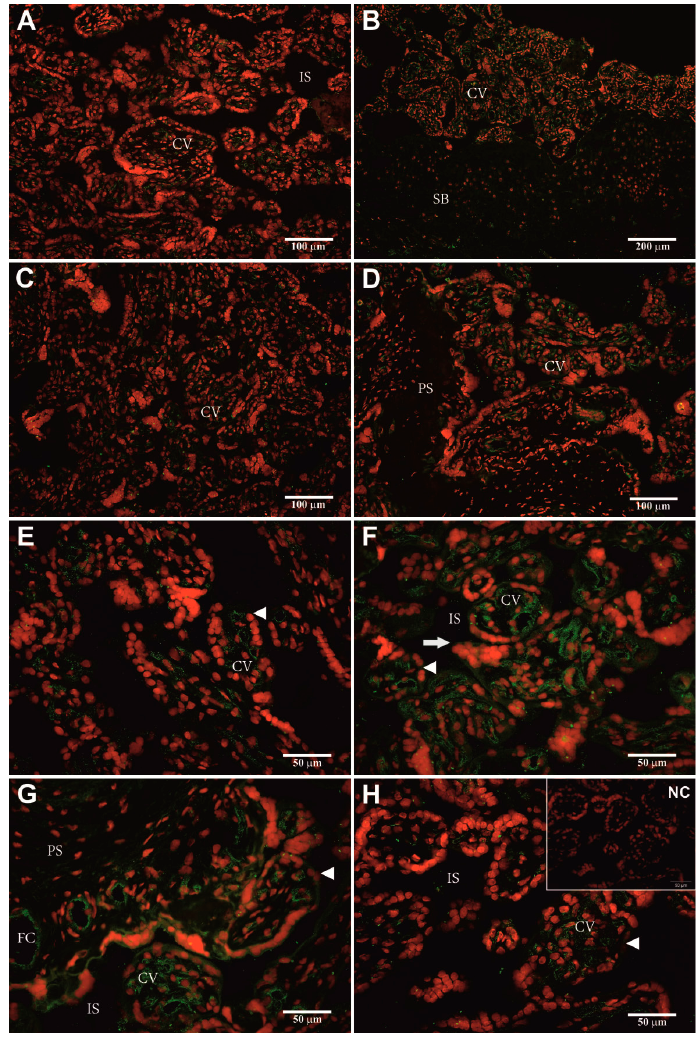
Figure 5. Heterologous immuno-localization of the hPAG-L/pep proteins within sections of human term placenta identified with recombinant anti-porcine PAG (anti-Rec pPAG2) polyclonals ( A–H ), visualized by goat anti-rabbit IgG-conjugated with Alexa 488 fluorophore (green) among all nuclei stained by propidium iodide (red). Human placenta section—used as a negative control (NC; insert in H ) with omitted polyvalent anti-pPAG-P polyclonals. The size bars are 50 µm ( E – H and NC), 100 µm ( A , C , D ) and 200 µm ( B ). Abbreviations: arrowheads—syncytiotrophoblast; arrows—clusters of